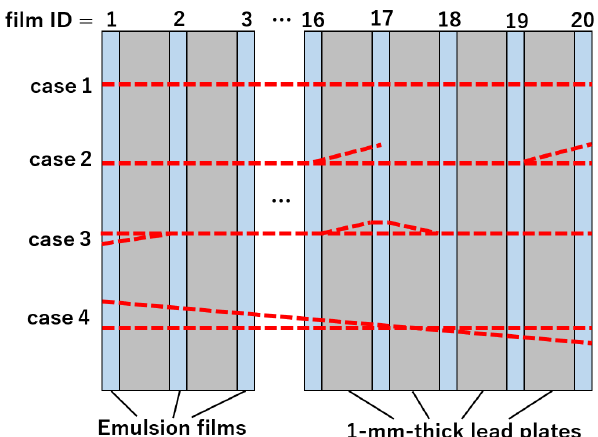
Figure 6. Schematic examples of typical reconstructed tracks in an ECC obtained by NETSCAN 2.0. Upstream means towards the vol- canic cone side and downstream means the backward free sky direc- tion. Case 1: a straight track without any branches. Case 2: a straight track with a branch in the middle and downstream films. The track branch in the middle was rejected by selection step 1. The branch in the most downstream film was merged into the straight track by se- lection step 3a. Case 3: branches in the upstream and middle films. Both branches were merged into a straight track by selection step